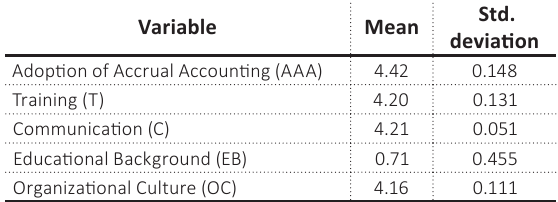
Table 3. PLS path analysis coefficient